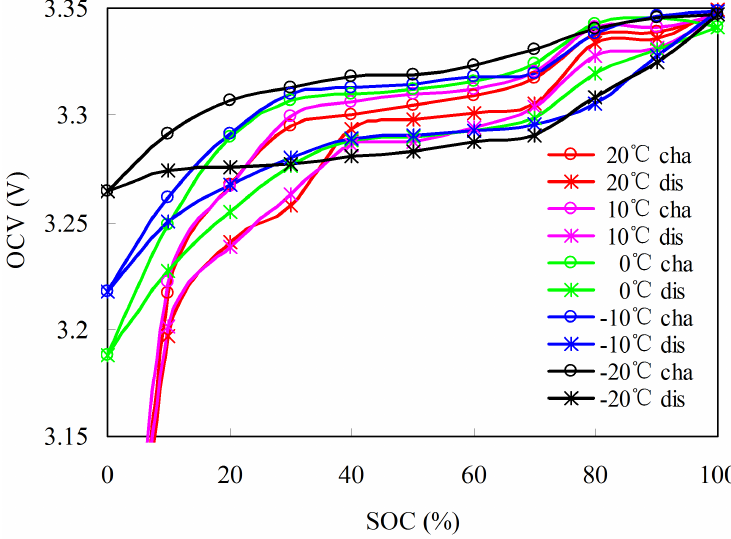
Figure 16. Charged and discharged L–L non-rated OCV–SOCs with respect to